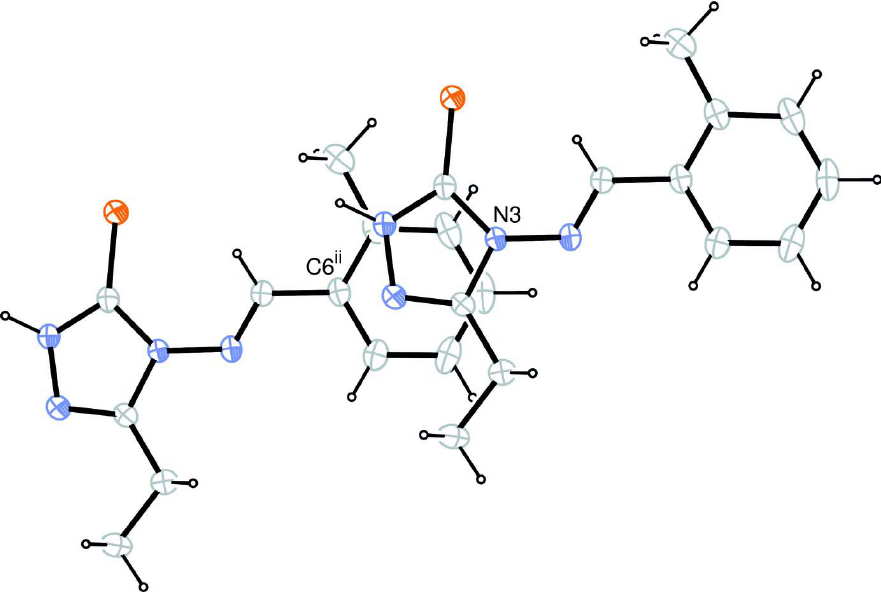
Figure 1 The molecular structure of the title compound with 40% probability displacement ellipsoids for non-H atoms. Dashed line indicates hydrogen